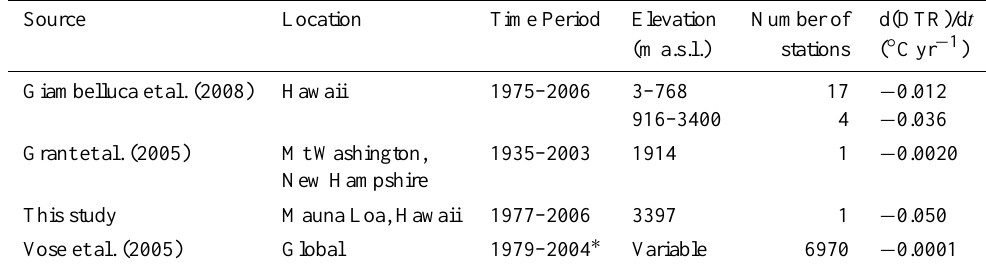
Table 1. Diurnal temperate range (DTR) studies compared [ma.s.l.=metres above sea level]. Source